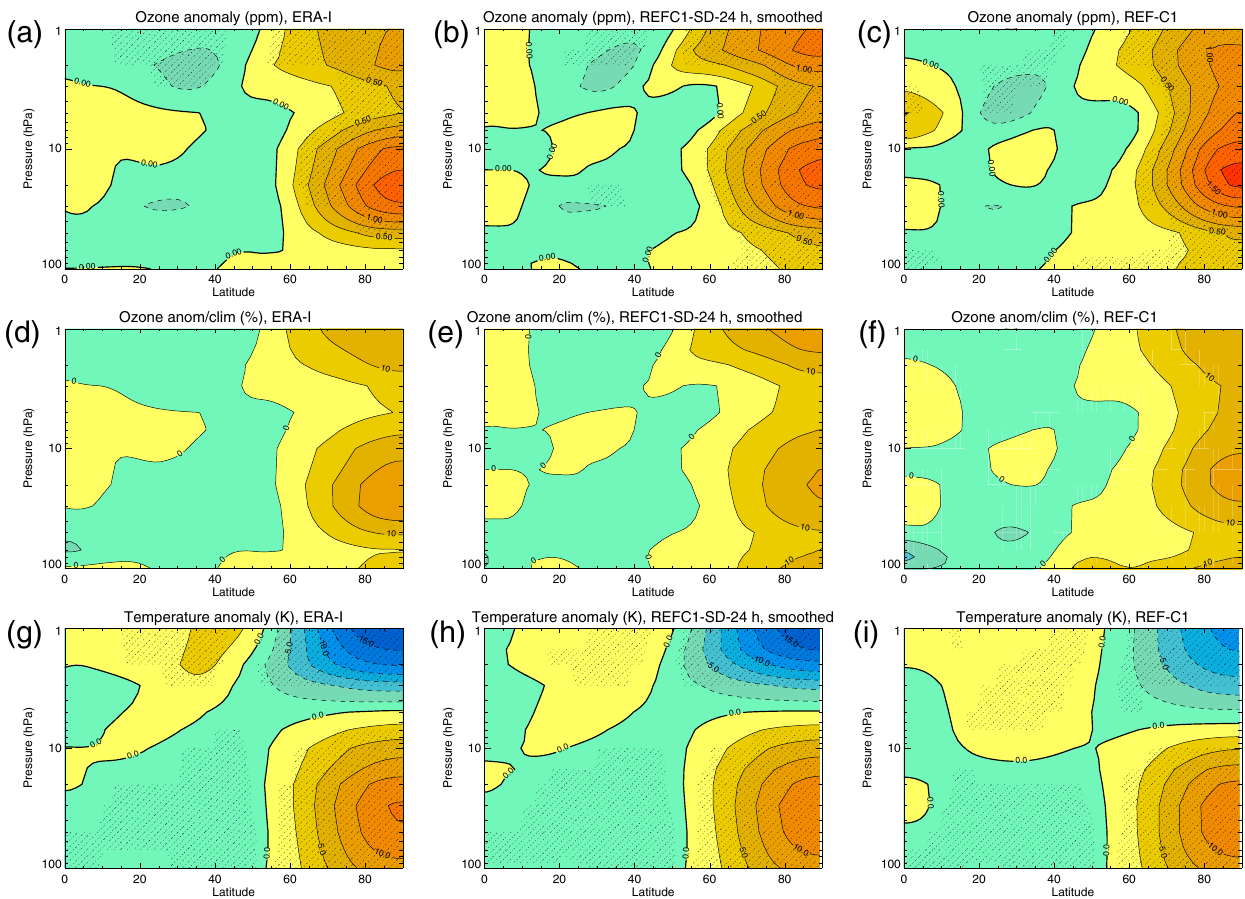
Figure 16. Anomalies, averaged over the 30 days following a stratospheric sudden warming, in (a) – (c) ozone volume mixing ratio (ppmv), (d) – (f) ozone as a percentage of climatological values, and (g) – (i) temperature (K) for ERA-Interim, the 24h nudged simulation, and the free-running REF-C1 simulation. Stippling shows regions where the anomalies are statistically significantly different from zero, with 95% confidence, as calculated using a t test.